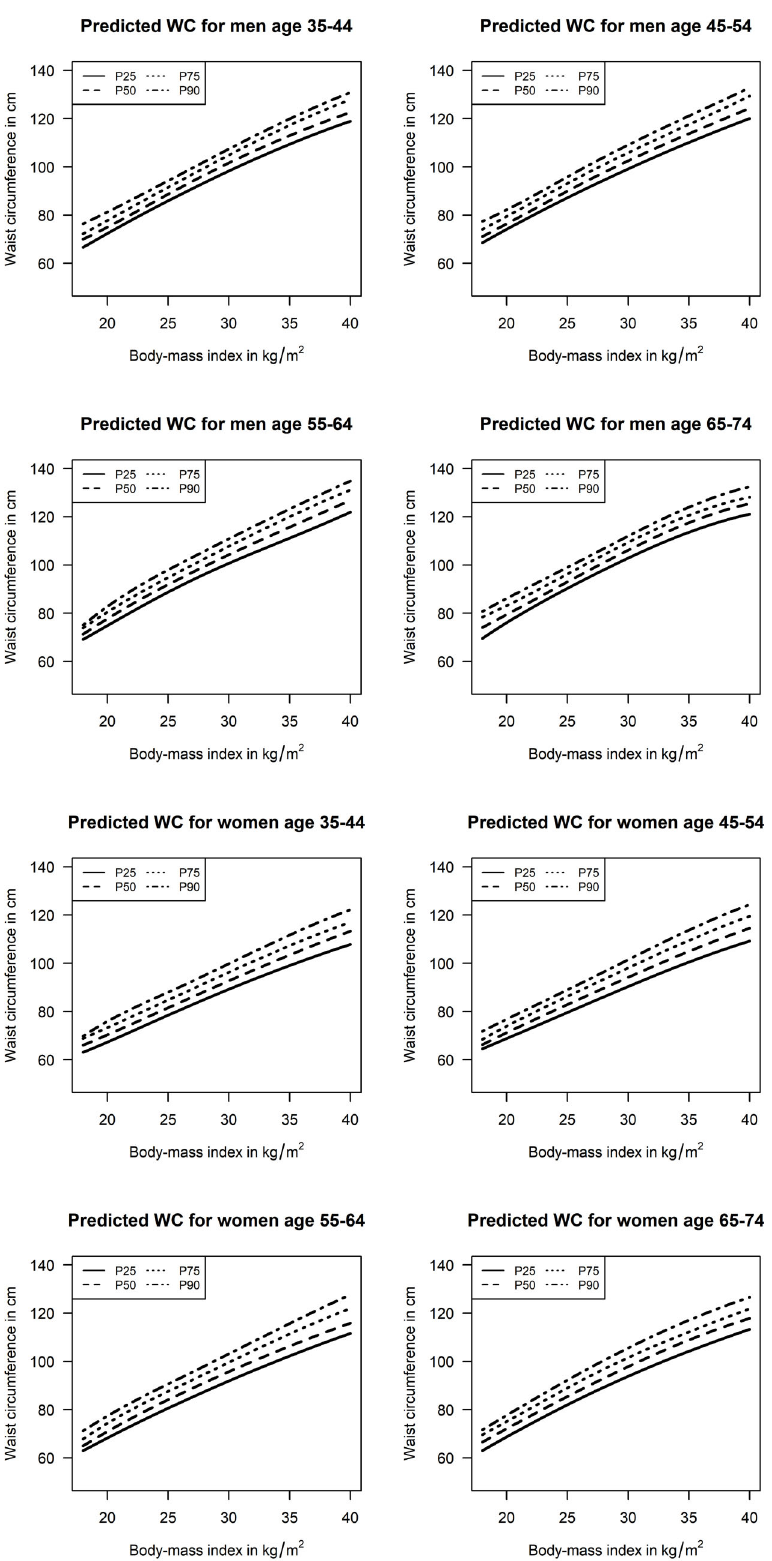
Figure 1. Predicted 25th, 50th, 75th, and 90th percentiles for waist circumference (WC) values according to age, body mass index, and